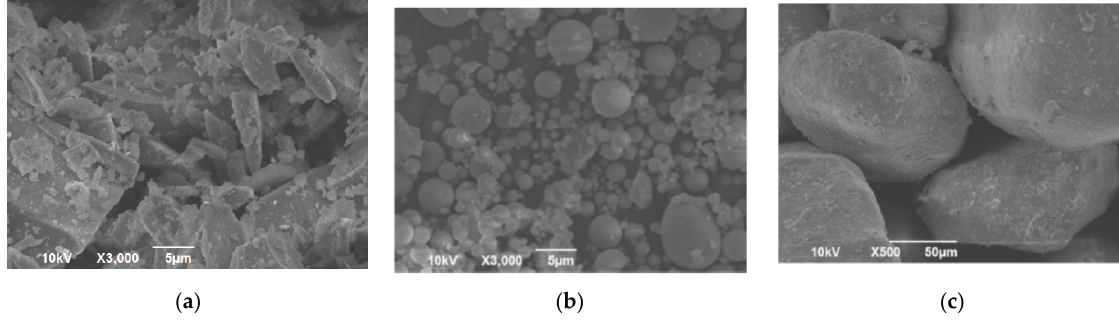
Figure 2. SEM micrographs of ( a ) slag, ( b ) fly ash, and ( c ) dune sand.